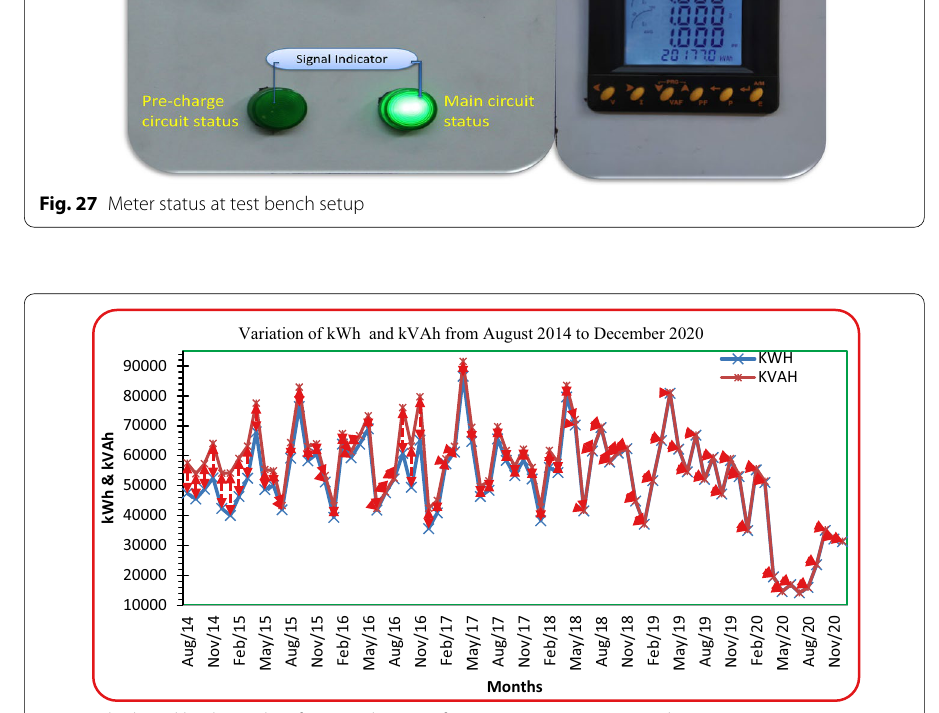
Fig. 28 kWh and kVAh graphs of SUES Substation from August 2014 to December